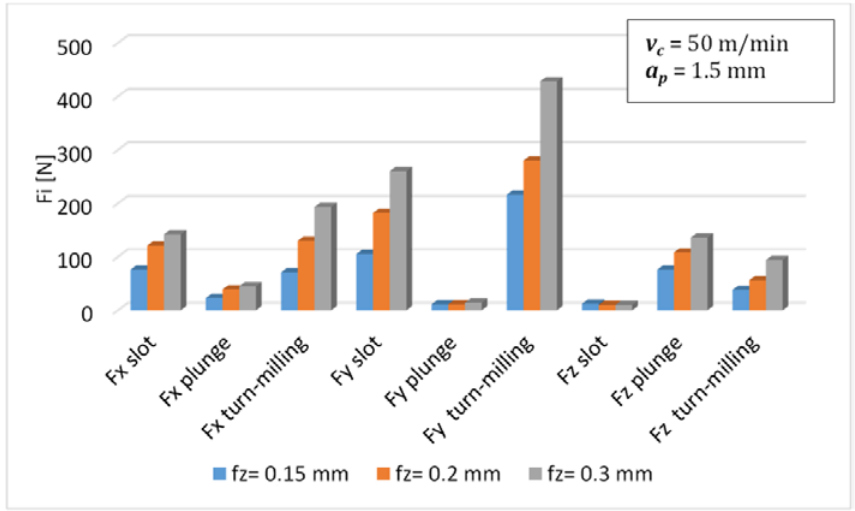
Figure 18. The influence of feed fz on forces for different machining types.